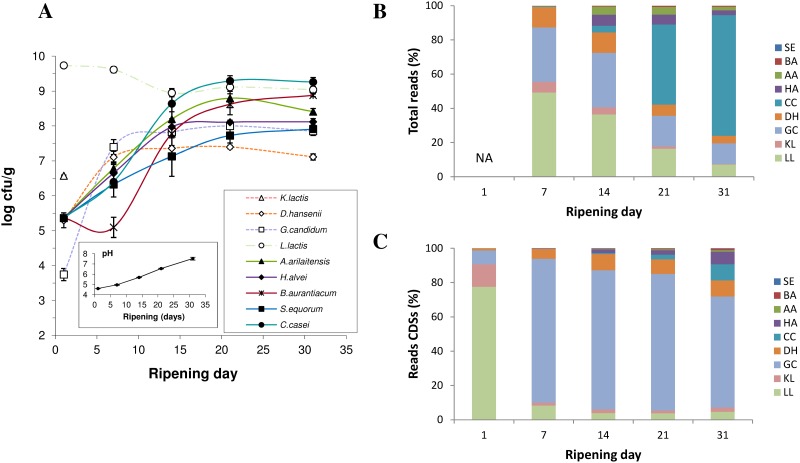
Changes in the microbial community structure during surface-ripened cheese maturation.(A) Microbiological counts and pH measurements. (B) Distribution of metagenomic data by species. (C) Distribution of metatranscriptomic data by species (only reads mapping CDS features were taken into account). SE: Staphylococcus equorum. BA: Brevibacterium aurantiacum. AA: Arthrobacter arilaitensis. HA: Hafnia alvei. CC: Corynebacterium casei. DH: Debaryomyces hansenii. GC: Geotrichum candidum. KL: Kluyveromyces lactis. LL: Lactococcus lactis. NA: data not available.